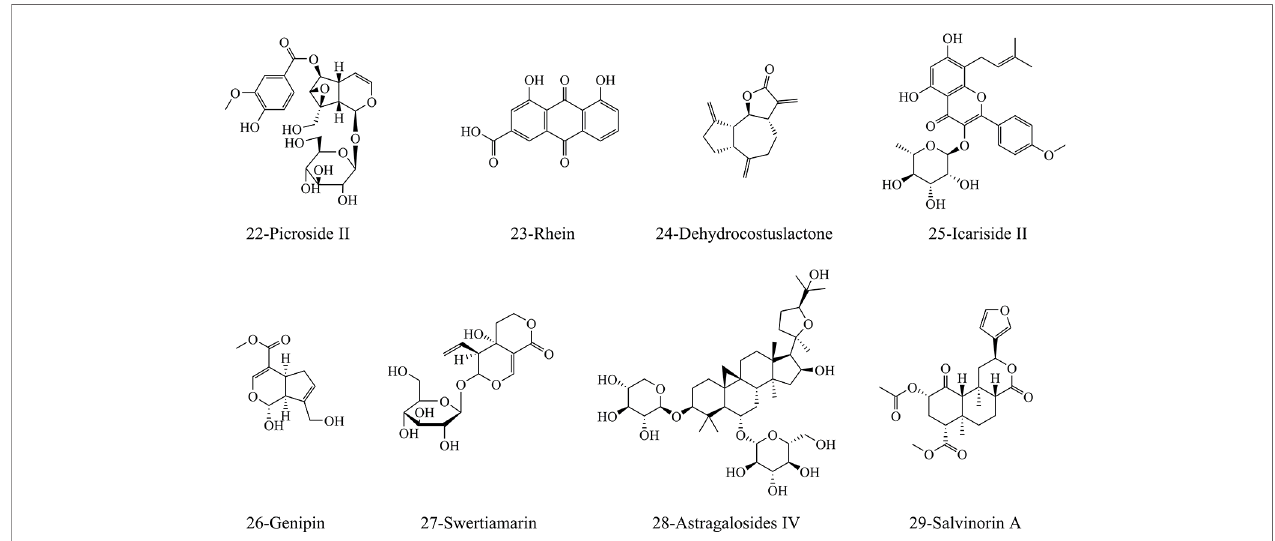
FIGURE 3 | The structural information of underlying compounds for regulation of MPTP opening to inhibit apoptosis in ischemic neurons. The structural formulae of 29 monomer compounds are shown in the fi